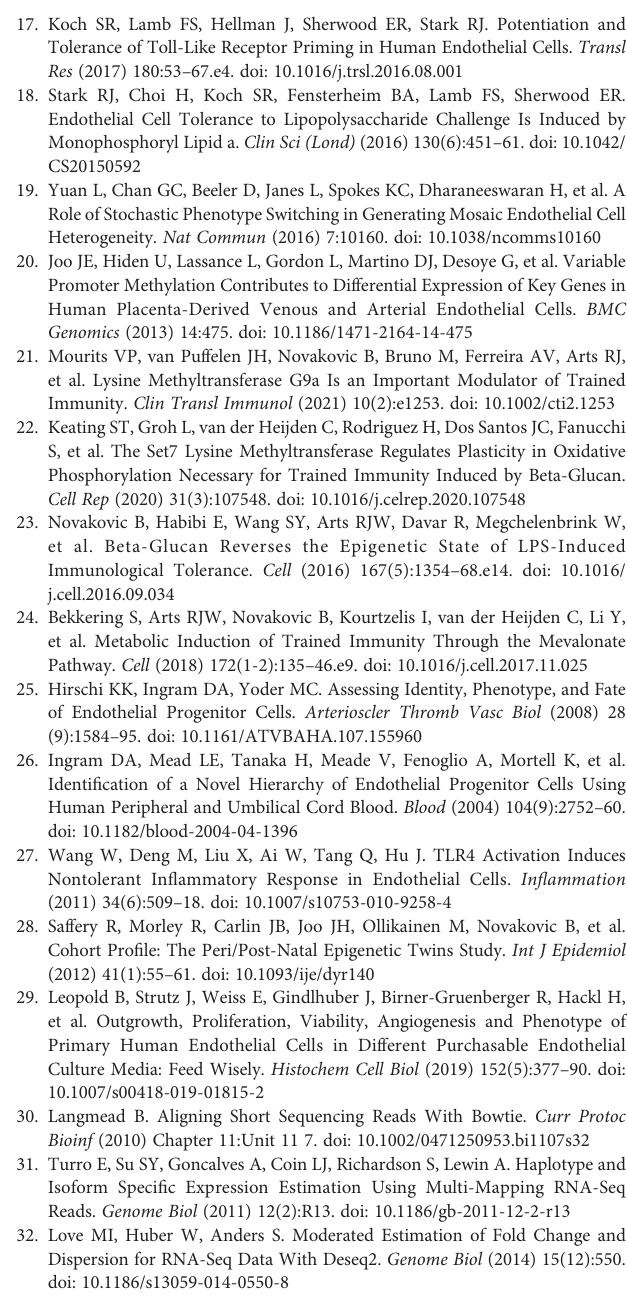
and HUVECs. (A) Abundance of transcription factor motifs in promotors of Poly(I:C) induced genes. (B) Transcription factor genes related to the motif signature are higher in HUVECs than ECFCs. Supplementary Figure 4 | Summary of genes trained or tolerized for LPS response by Poly(I:C) in HUVECs and ECFCs. (A) PCA plot of transcriptomic changes that occur 4 hours following LPS exposure after previous stimulation with Poly(I:C) or media only. (B) Expression of trained, unaffected and tolerized genes overtimeinHUVECs.GenestrainedforLPSresponsearemorestronglyinducedby Poly(I:C) compared to genes that are tolerized for LPS response. (C) Line plot showingexpression ofexample trained, unaffected and tolerized genes (greenline – ECFCs, blue line – HUVECs, black line – media